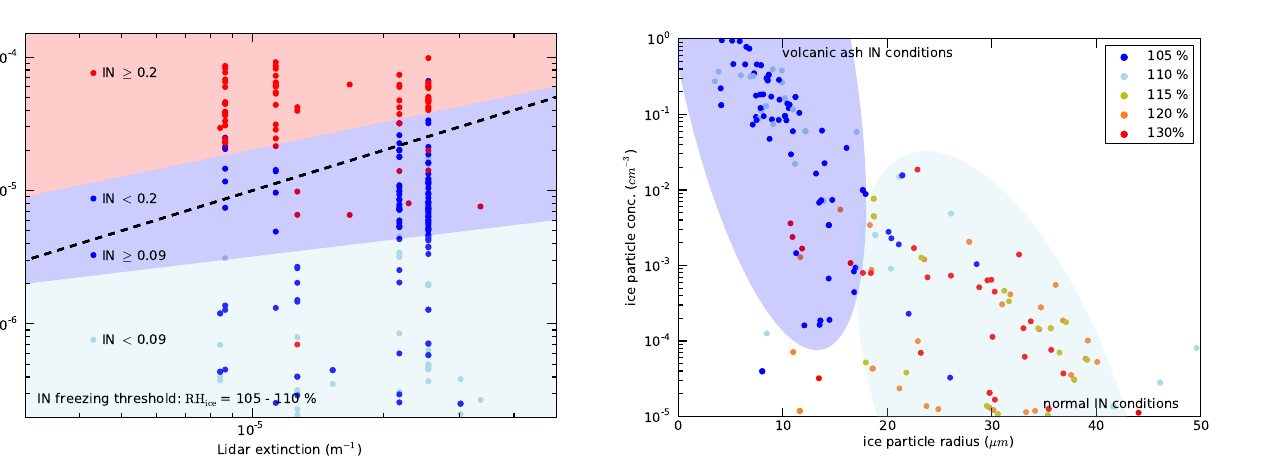
Fig. 5. Scatterplot of observed (lidar) and simulated (MAID) cirrus extinction. For each observed extinction, model simulations with varying IN concentration are performed to find the IN concentra- tion where simulation and observation best matches. Red: high IN concentration ( ≥ 0.2cm − 3 ), blue: medium (0.09–0.2cm − 3 ), light blue: low ( < 0.09cm − 3 ). The black dashed curve represents the 1:1 line between lidar and MAID extinction. The freezing threshold of the IN is set to 105–110% RH ice .